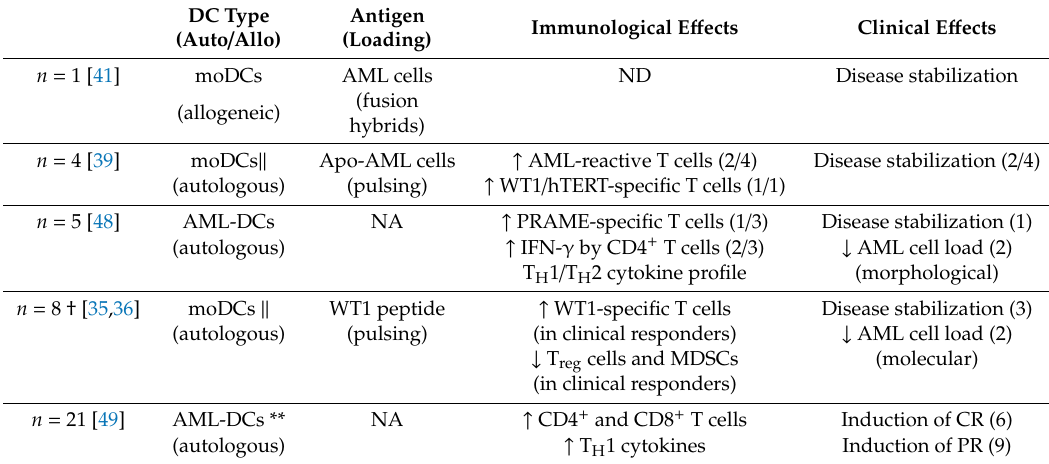
Table 2. Overview of DC vaccine studies for AML in an advanced disease